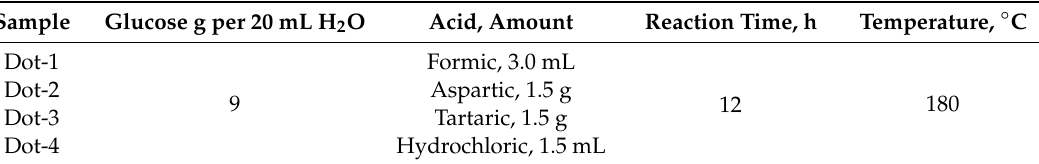
Table 4. CQDs synthesis